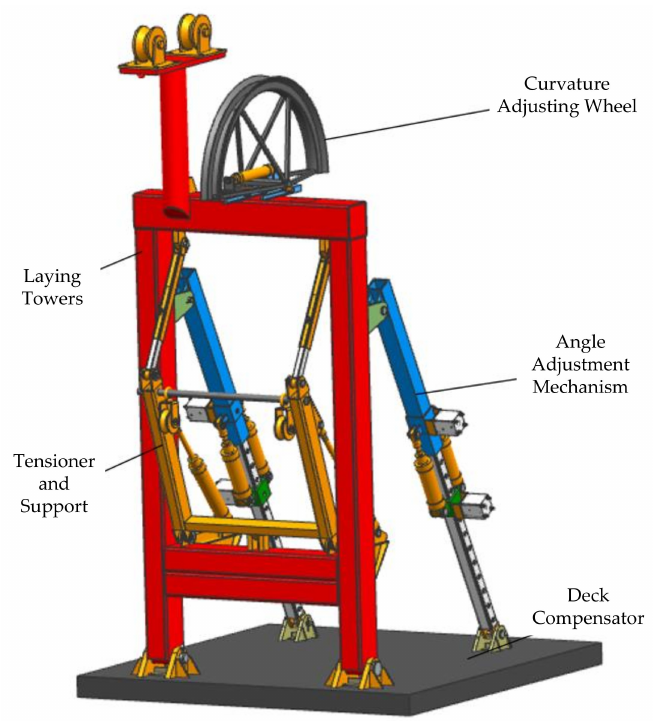
Figure 4. Experimental scaled model diagram of flexible pipeline-laying